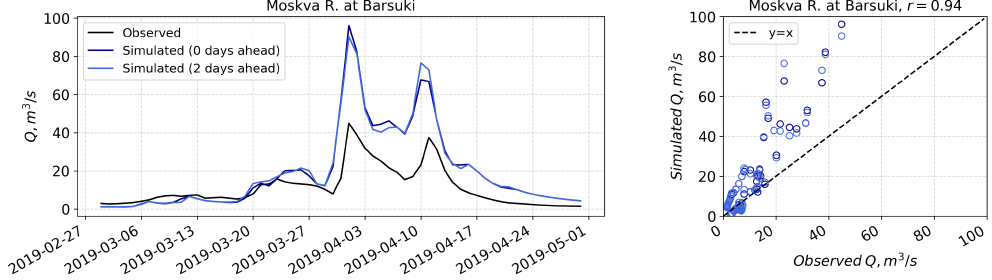
Figure 5. Hydrographs ( left plot ) and scatter plot ( right plot ) of observed and simulated discharges for Moskva R. at Barsuki during the 2019th spring flood.